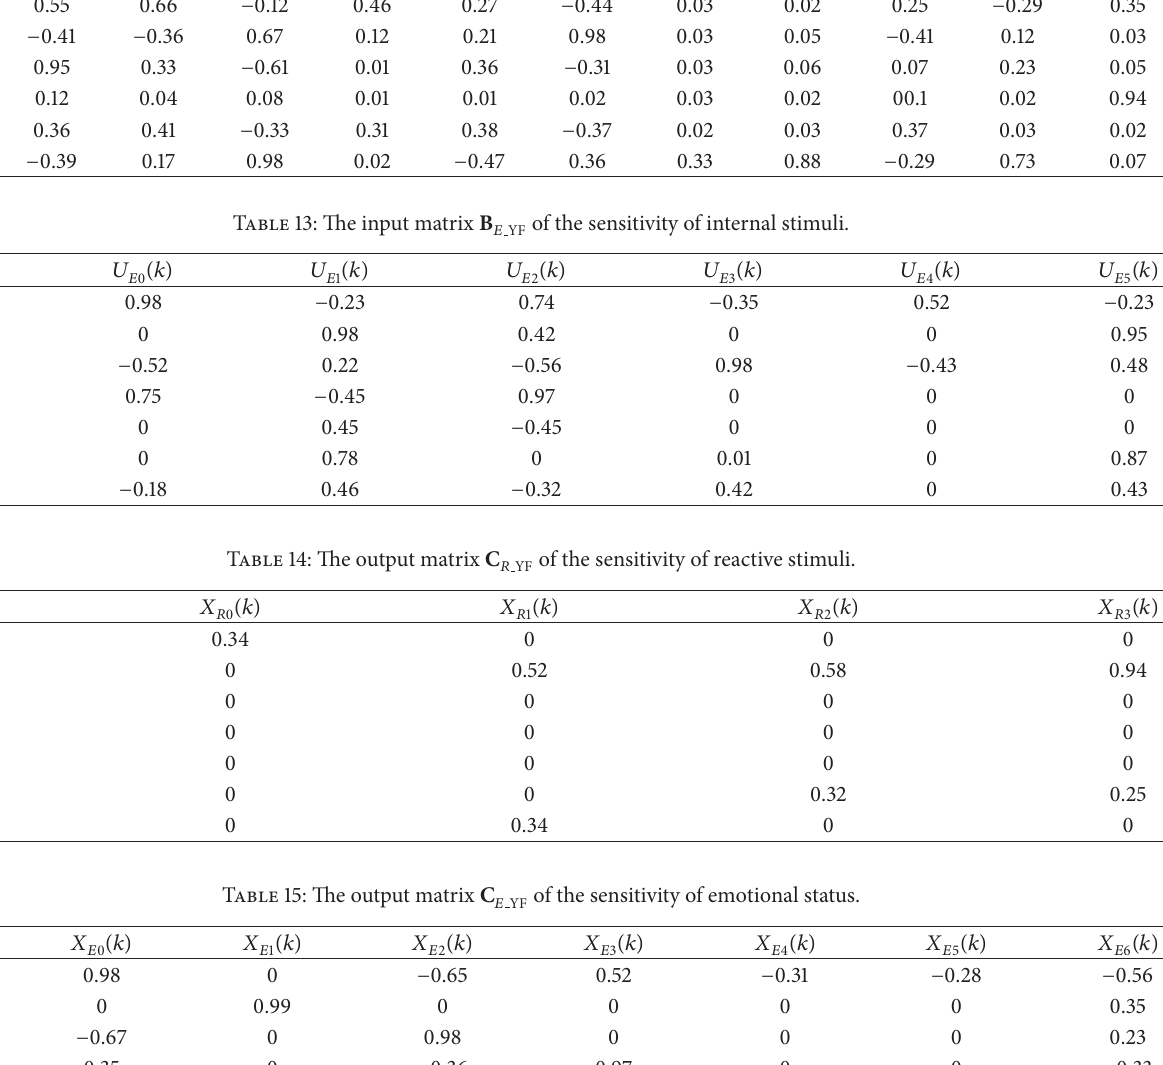
Table 12: The input matrix B 𝐼